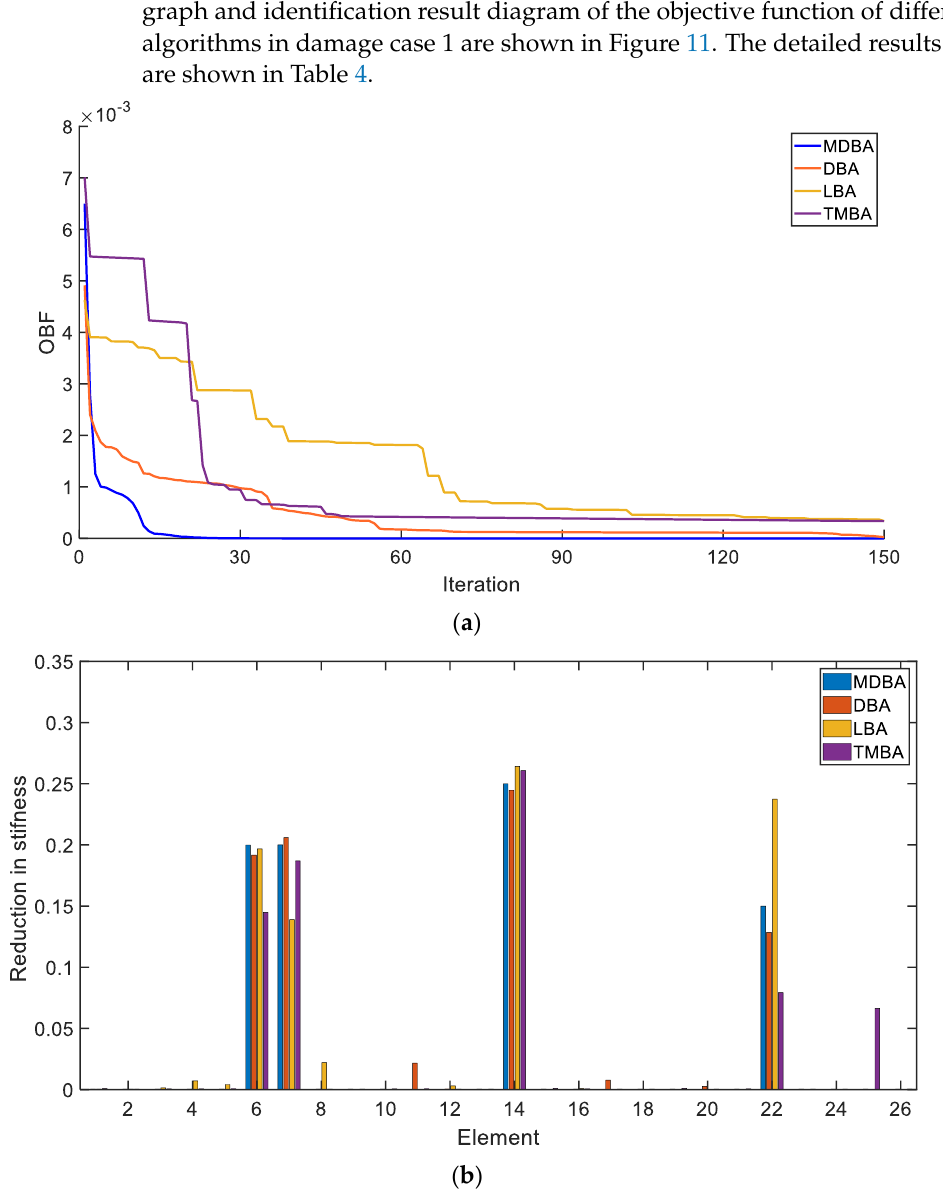
Figure 11. ( a ) The convergence curves achieved by other variations of BA for the objection function. ( b ) The identification results of the damaged case by other variations of BA. Table 4. The identification results of the damaged case by other variations of BA. Damage Severity (Relative Error) Obvious Error Alarm Algorithm Damage Element 6 Damage Element 7 Damage Element 14 Damage Element 22